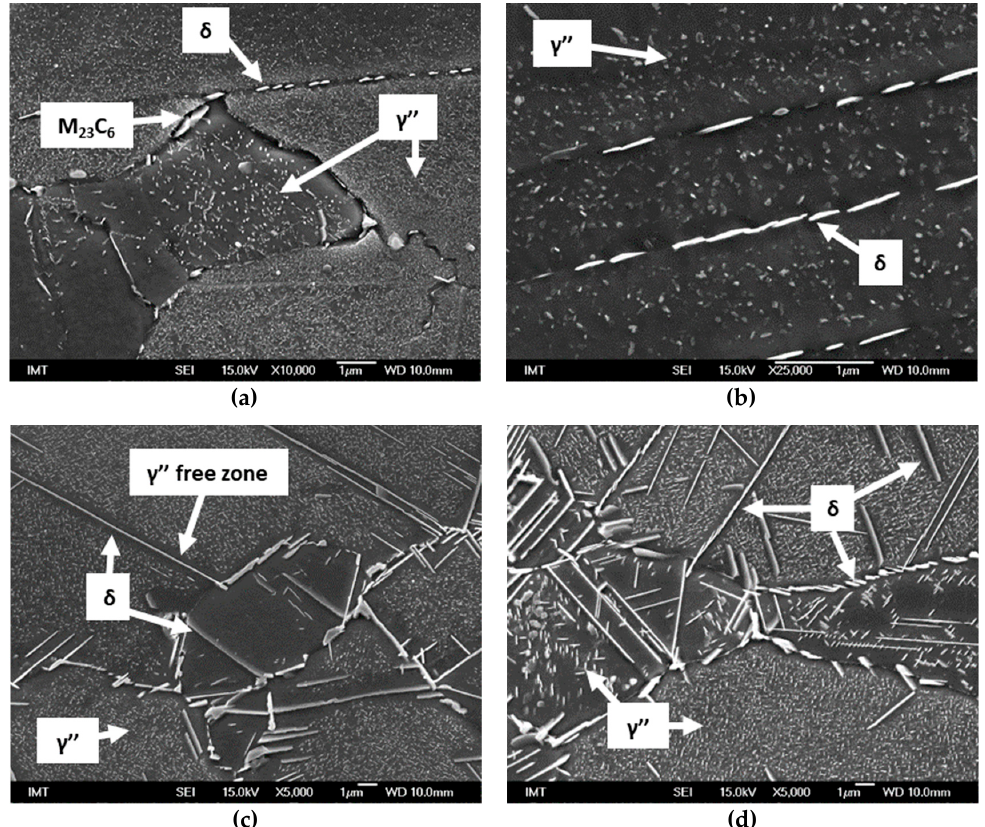
Figure 14. Large γ ” precipitates and smaller ones along the twin of the sample hot rolled at 1050 ◦ C Figure 14. Large γ ’’ precipitates and smaller ones along the twin of the sample hot rolled at 1050 °C with the deformation level of 23.5% and aged at 750 ◦ C for 25 h ( a ). The transition from segregation with the deformation level of 23.5% and aged at 750 °C for 25 h ( a ). The transition from segregation band in the sample hot rolled at 1150 ◦ C with the deformation level of 25.2% and aged at 750 ◦ C for band in the sample hot rolled at 1150 °C with the deformation level of 25.2% and aged at 750 °C for 125 h ( b ). 125 h ( b ).